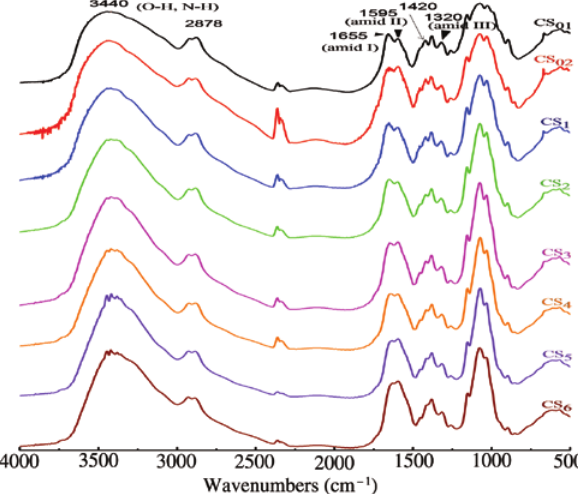
), chitosan soaked 01 ), 8 (CS ), 12 (CS 1 2